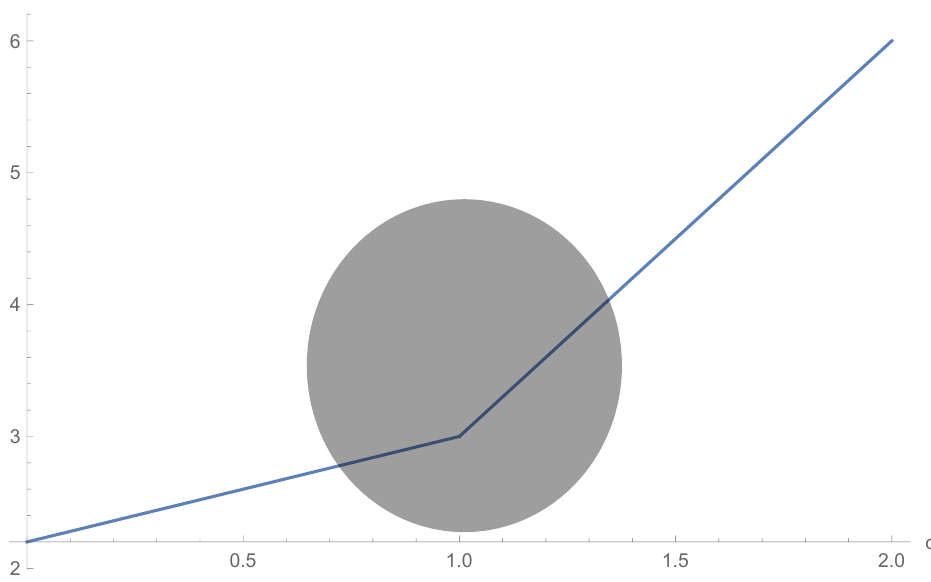
Figure 24. A schematic acceleration scheme of a particle in an Euclidean portion of